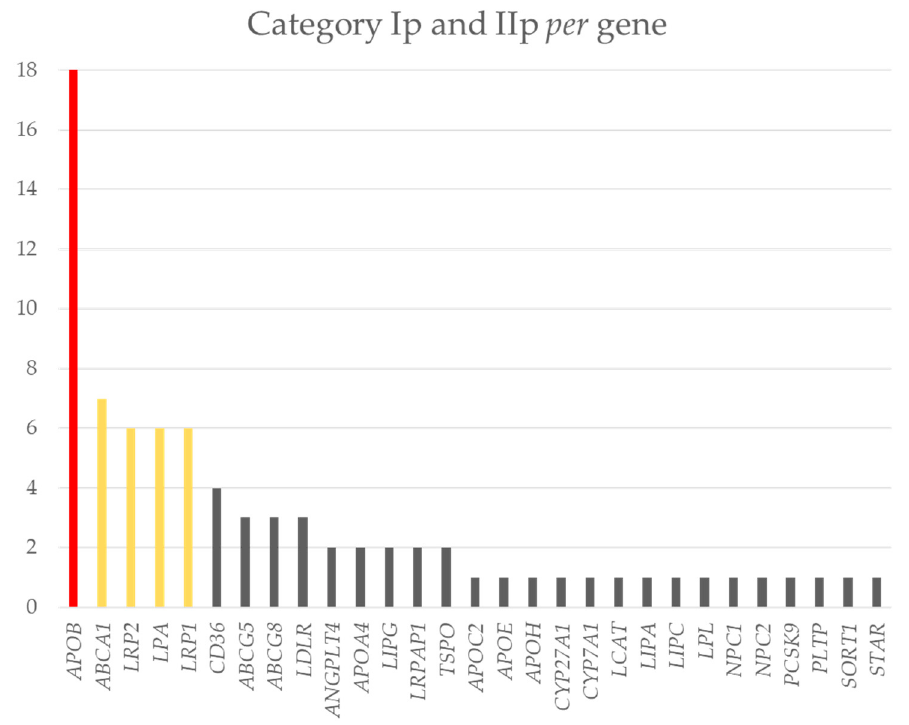
Figure 3. Bar graph displaying the number of mutations and potential mutations (Y axis) per gene (X axis). Red: more than 8 variants; yellow: between 8–6 variants; grey: less than 6 variants.